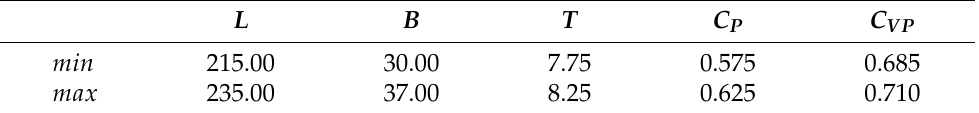
Table 1. Free variables and applied ranges for the generation of LCTC design alternatives.